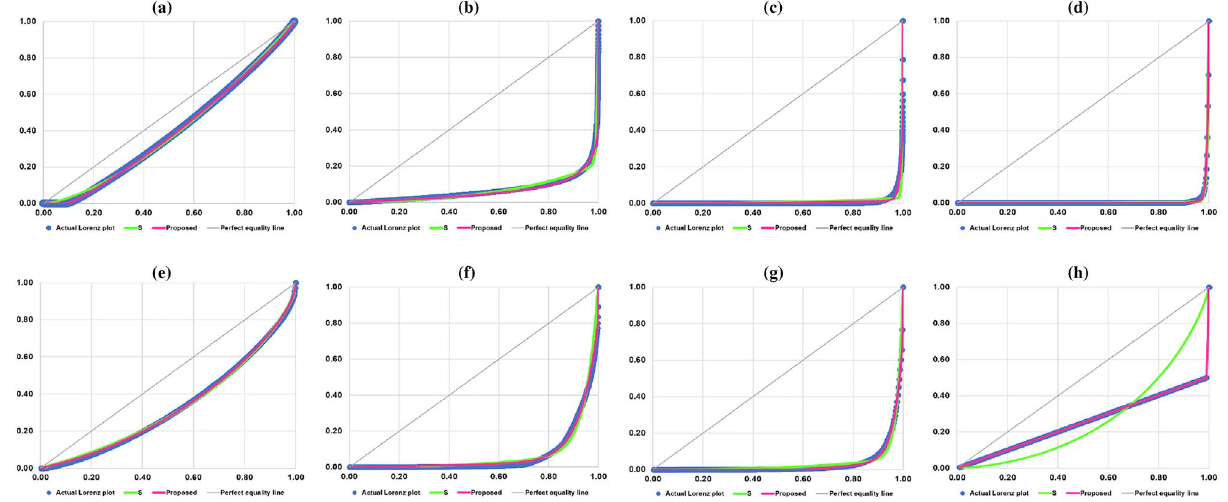
Figure 3. The actual Lorenz plots and the estimated Lorenz curves based on the proposed model and the S model. ( a ) Earthquake intensity. ( b ) Solar flare intensity. ( c ) Mammal body mass. ( d ) Metabolic